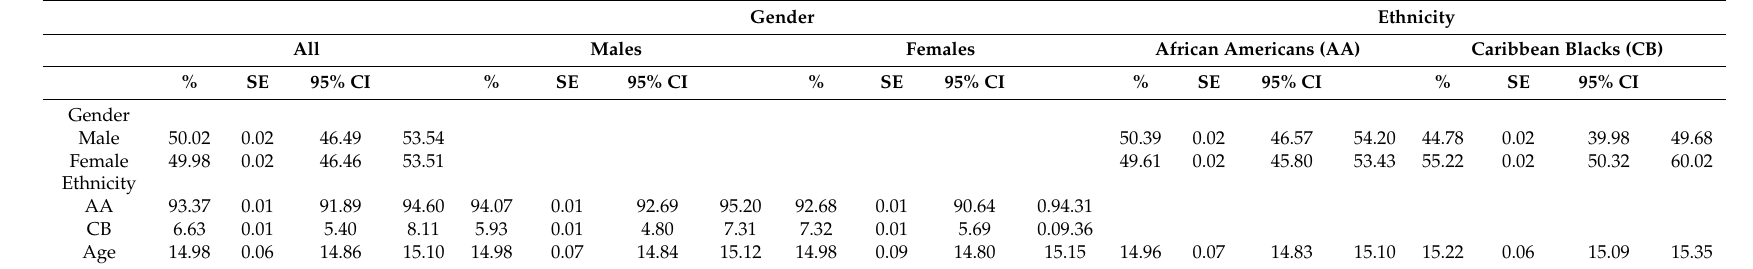
Table 1. Descriptive statistics in the pooled sample and based on ethnicity and